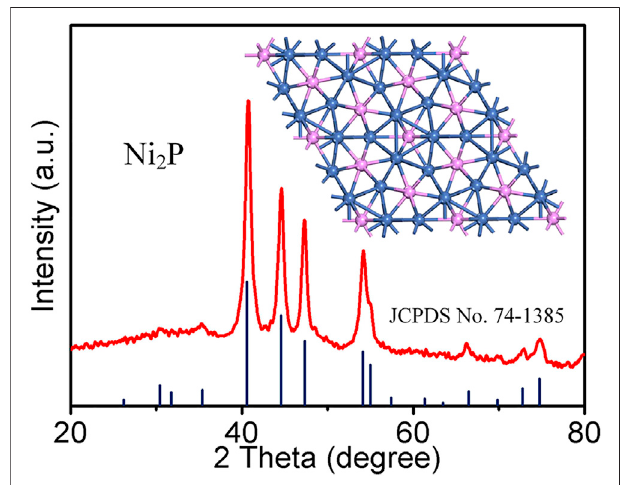
FIGURE 1 | XRD pattern of the as-synthesized Ni 2 P